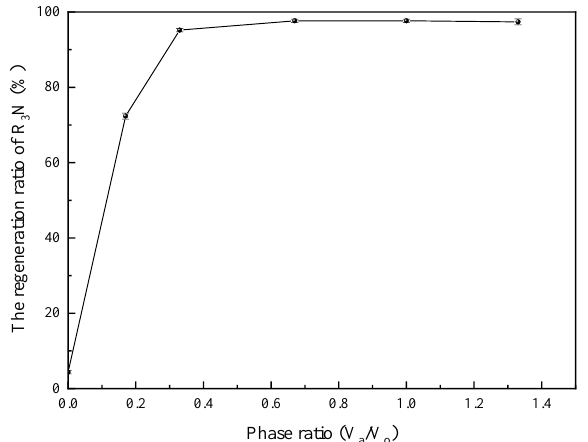
Figure 4. Effect of phase ratio between aqueous and oil phases on R 3 N regeneration rate at stirring speed = 300 rpm, reaction time = 420 s, and reaction temperature = 353.15 K.